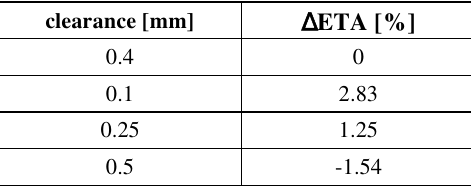
Table 2. Deviations of the efficiency .